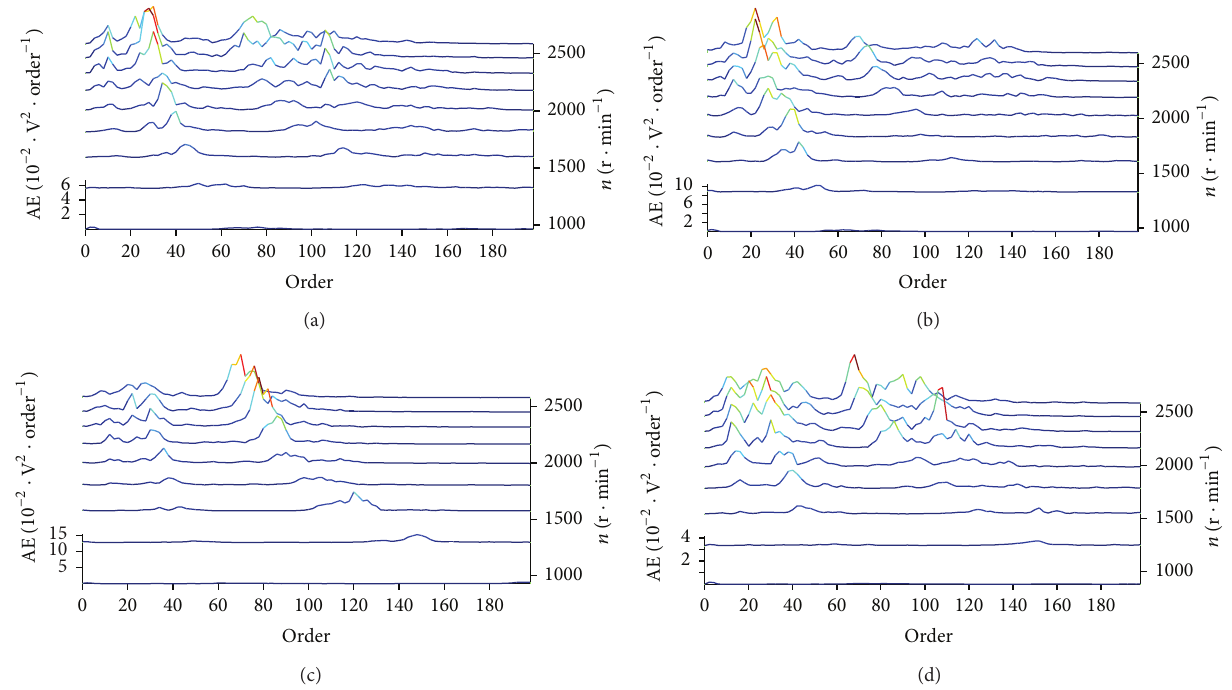
Figure 5: Order tracking spectrum of different bearing clearance (degree of wear: (a) normal, (b) slight, (c) moderate, and (d) severe).